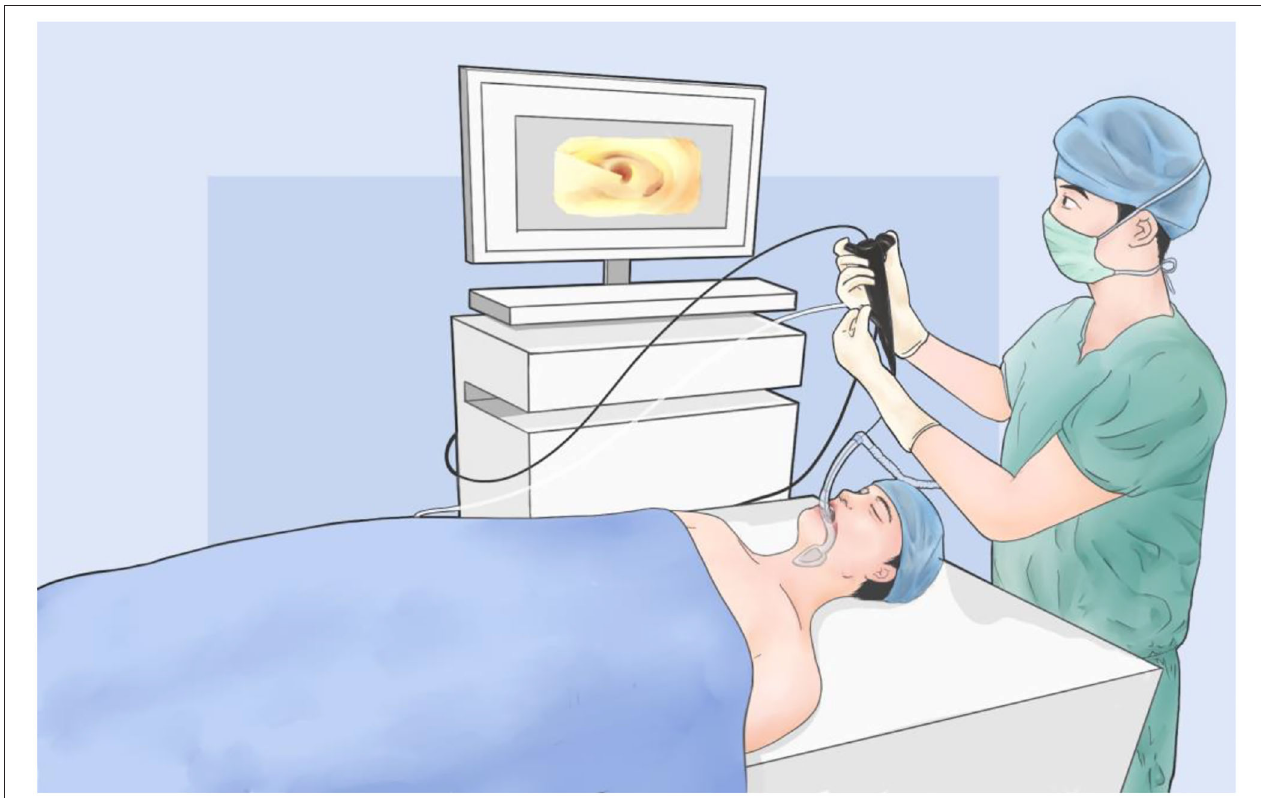
FIGURE 1 | The diagram of electromagnetic navigation bronchoscopy ( ENB) for pulmonary nodule localization.